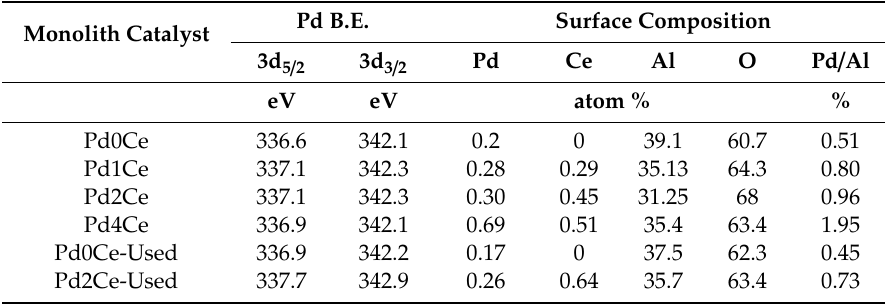
Table 3. XPS analysis of PdO / CeO 2 / γ -AlOOH / γ -Al 2 O 3 monolith catalysts with varying Ce content.